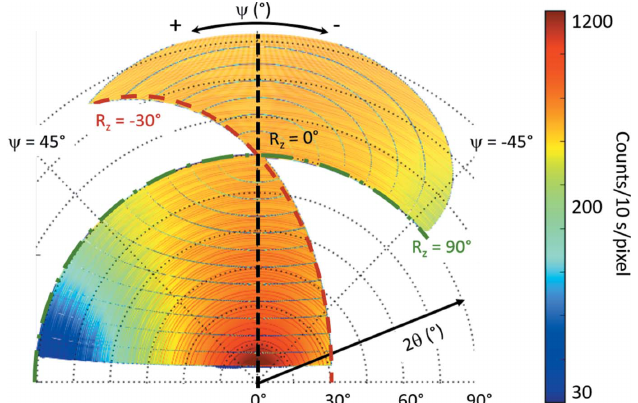
Figure 17 Polar representation (radius is 2 (cid:2) and azimuthal is ) of the accessed angular volume during a measurement with the CirPAD for R z = (cid:4) 30 to +90 (cid:3) (step of 1 (cid:3) ). The trajectories, in angular space, of the reconstructed data from single CirPAD images, are shown for the cases R z = (cid:4) 30, 0 and 90 (cid:3) (red, black and green dashed curves, respectively). The intensity colour scale (from blue to red) is logarithmic. The presence of the missing data corresponding to inter-module gaps appears as curved grey regions. Due to the very large size, the data were relatively strongly binned ( (cid:7) 20 (cid:2) 20 pixels, i.e. (cid:7) 0.2 (cid:2) 0.2 (cid:3) angular opening) for ease of being shown.